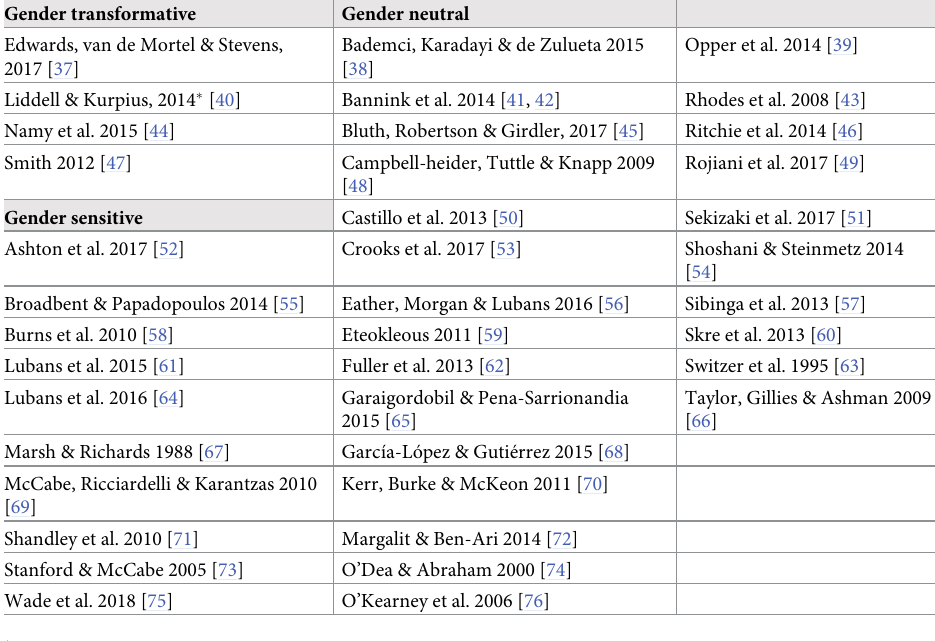
Table 2. Included articles categorised by intervention gender-focus.